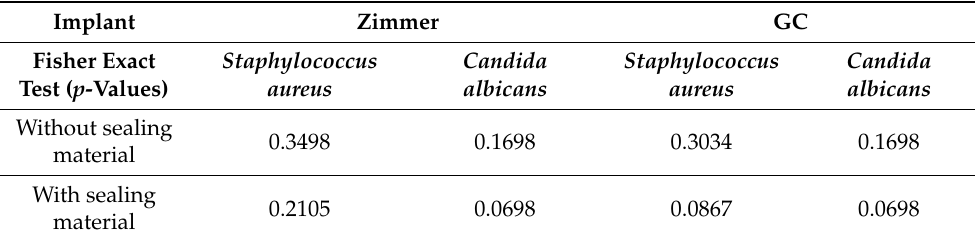
Table 4. Comparison of Fisher’s exact test values for microleakage with and without application of sealing material (GapSeal).